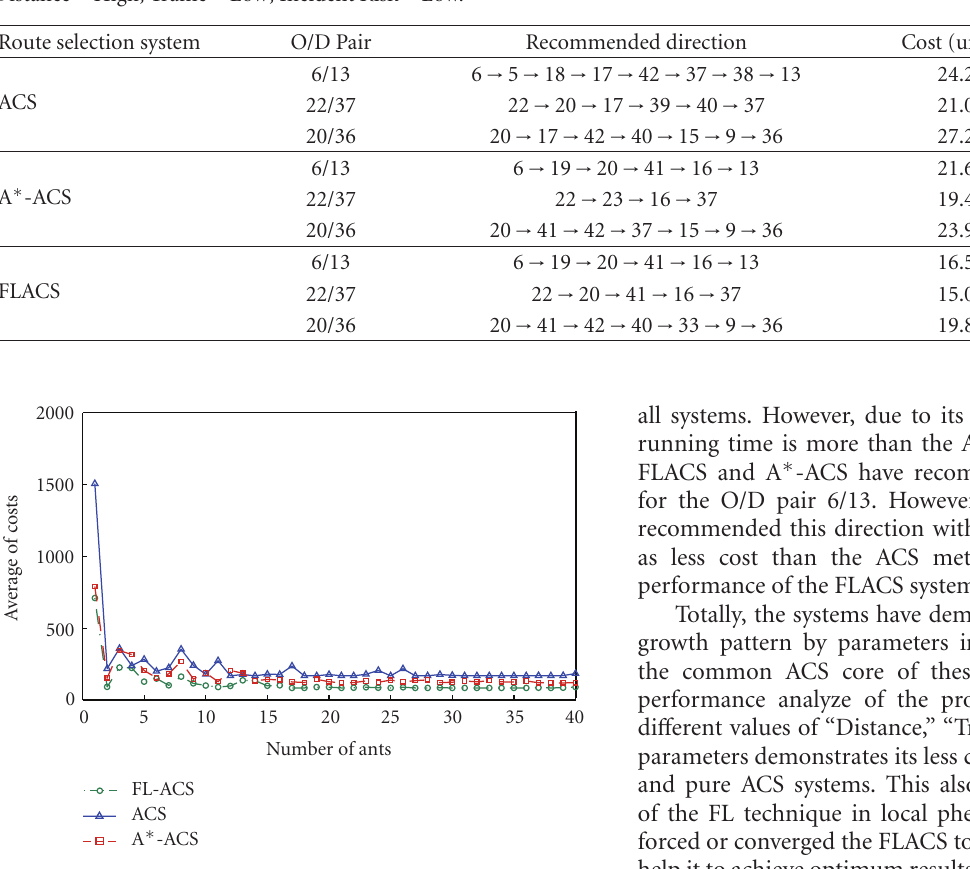
Table 2: Comparison between performance of ACS, A ∗ -ACS, and FLACS algorithms for three di ff erent O/D pairs and user preference: Distance = High; Tra ffi c = Low; Incident Risk = Low.